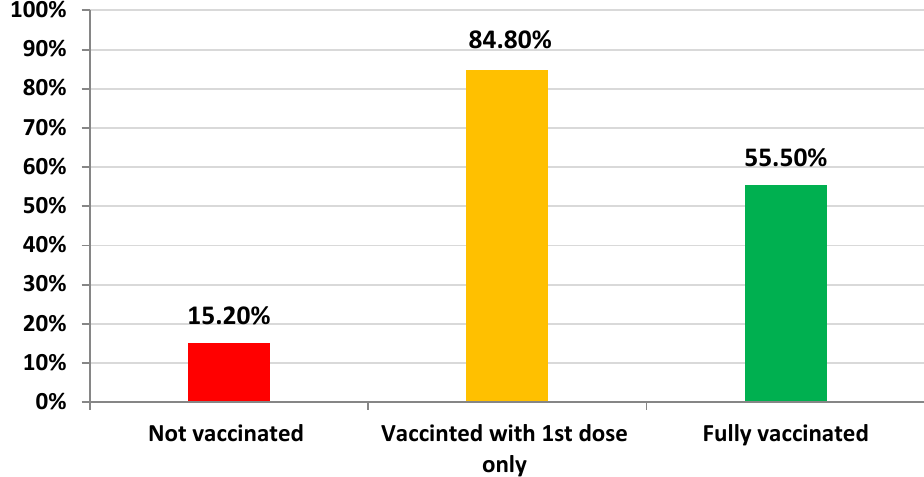
Figure 1. The rate of vaccination among patients with type 2 diabetes as of 16 July 2021 .